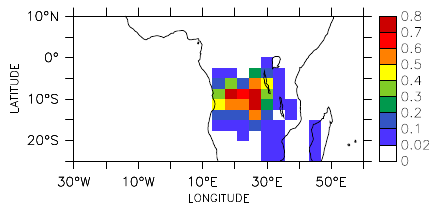
Fig. 7. CO 2 emissions from biomass burning in kg m − 2 day − 1 in July 2006 over South Africa derived Fig. 7. Mean CO 2 emissions from biomass burning in from observations conducted during the AMMA field campaign (Liousse et al., 2009) kgm − 2 day − 1 for July 2006 over Southern Africa as derived by (Liousse et al., 2010) and extrapolated to the GCM